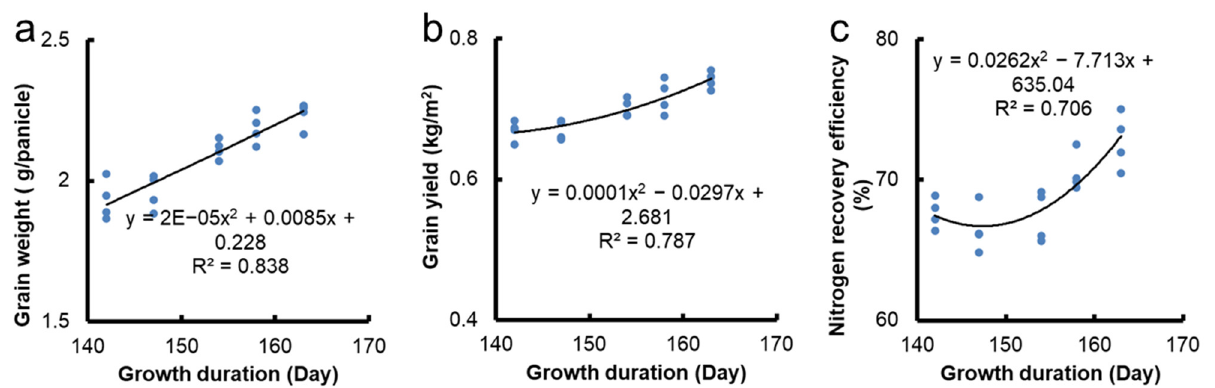
Figure 7. The relationships between growth duration and grain yield in O8 and EMS mutants. The relationships between growth duration and ( a ) grain weight ( p = 0.015), ( b ) grain yield ( p = 0.037) or ( c ) N recovery efficiency ( p = 0.048).